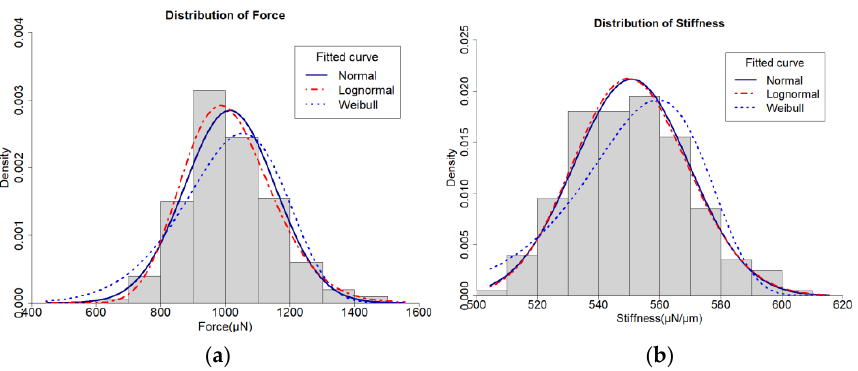
Figure 8. Distribution of the simulated yield force and stiffness: ( a ) Yield force; ( b ) Stiffness. To compare the deformation behavior between simulation and experiment, the de- formed cell network and the SEM picture of the specimen are displayed in Figure 9. The cell wall bending or buckling of earlywood was clearly seen in both experiments and simulation. The normal stress in the radial direction at the yield point and larger compression strain (0.2) are also displayed. It was found that the maximum stress was located at the inner side of the tracheid of earlywood. At larger compression strain, the earlywood cell wall began to touch each other, resulting in a hardening behavior as introduced before. It was found that the occurrence of the yield point was generally caused by the sudden change in the cellular structure, i.e., the bending or buckling of the earlywood axial tra- cheid cell wall.